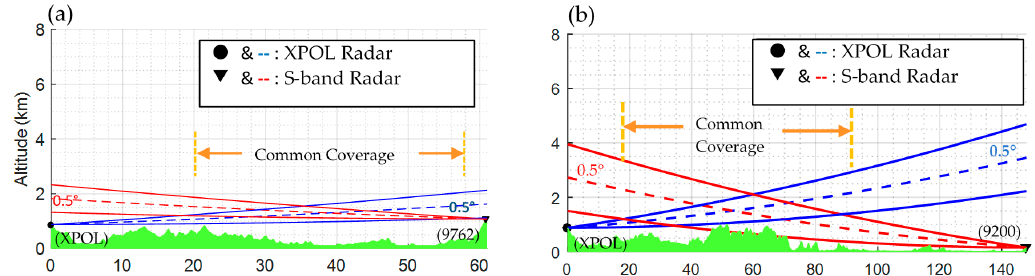
Figure 8. Reflectivity comparisons in common radial coverage between XPRAD and S-band CINRADs at the elevation of 0.5 ◦ . ( a ) spatial illustration of common radial coverage between XPRAD and CINRAD (9762), azimuth at 137 ◦ for XPRAD, azimuth at 317 ◦ for CINRAD (9762); ( b ) Same illustration like ( a ) between XPRAD and CINRAD (9200), azimuth at 215 ◦ for XPRAD, azimuth at 35 ◦ for CINRAD (9200). For radar data selection, only 0.5 ◦ PPI scans with a data collection time difference of less